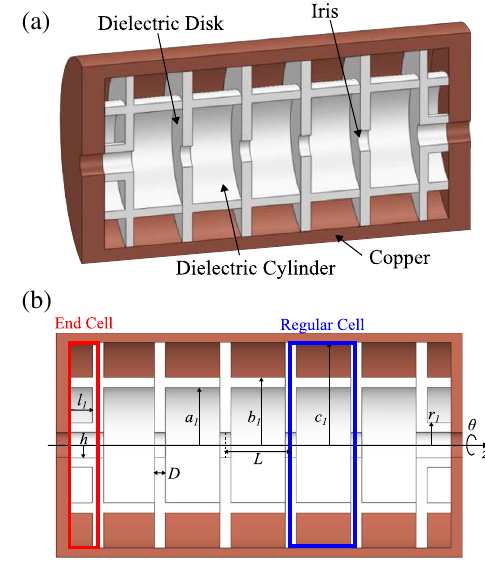
FIG. 1. (a) Conceptual illustration of a multicell DAA structure. (b) Longitudinal cross section of the DAA structure. Blue and red areas represent the regular cell and the end cell,